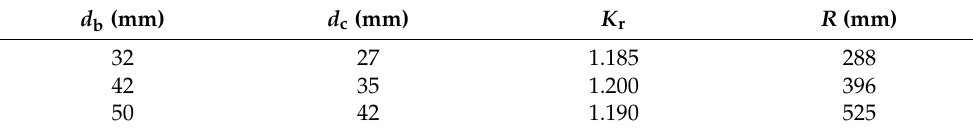
Table 2. Physical and mechanical parameters of rock. Table 3. Fracture radii under different charge